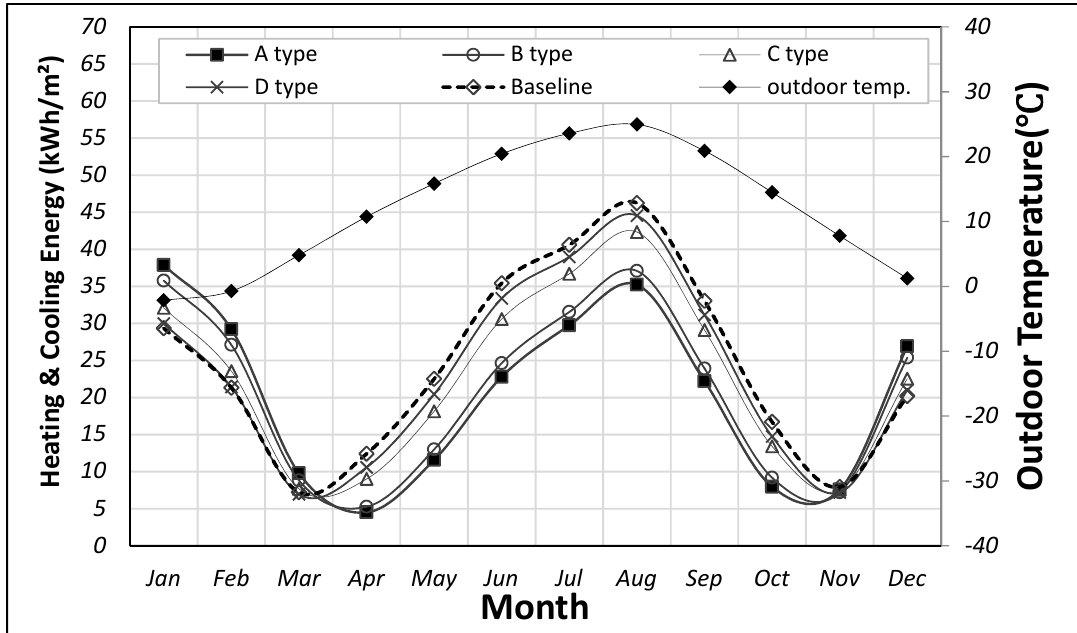
Figure 8. Analysis result of monthly heating and cooling energy consumption by PDLC film type.